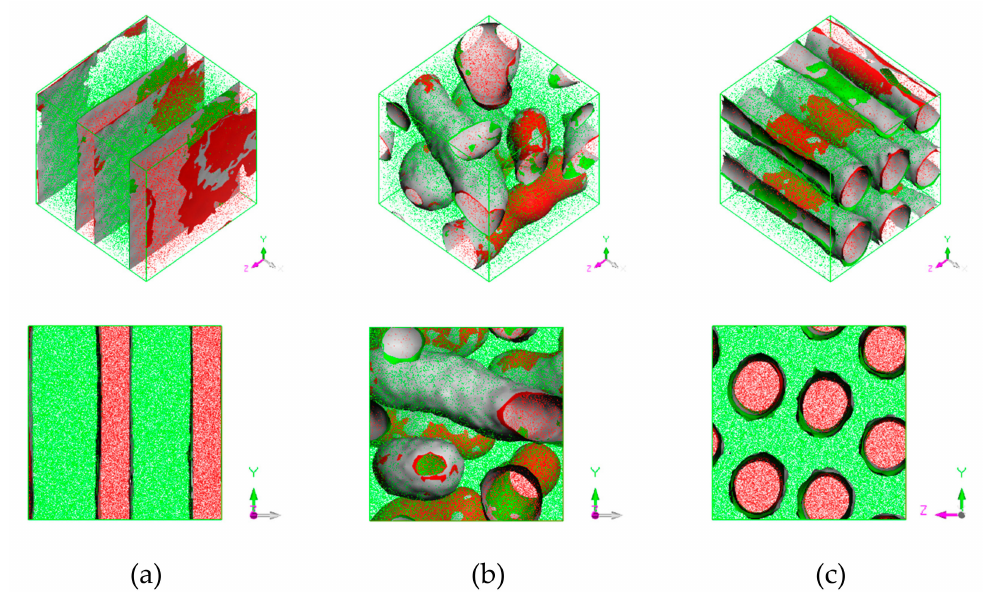
Figure 3. Phase morphology at ( a ) 393 K lamellar, ( b ) 493 K bicontinuous, and ( c ) 533 K hexagonally packed cylinder. Red region represents PS and green region represents PI. Red and green surfaces correspond to PS and PI isosurfaces, respectively, and gray corresponds to interface between